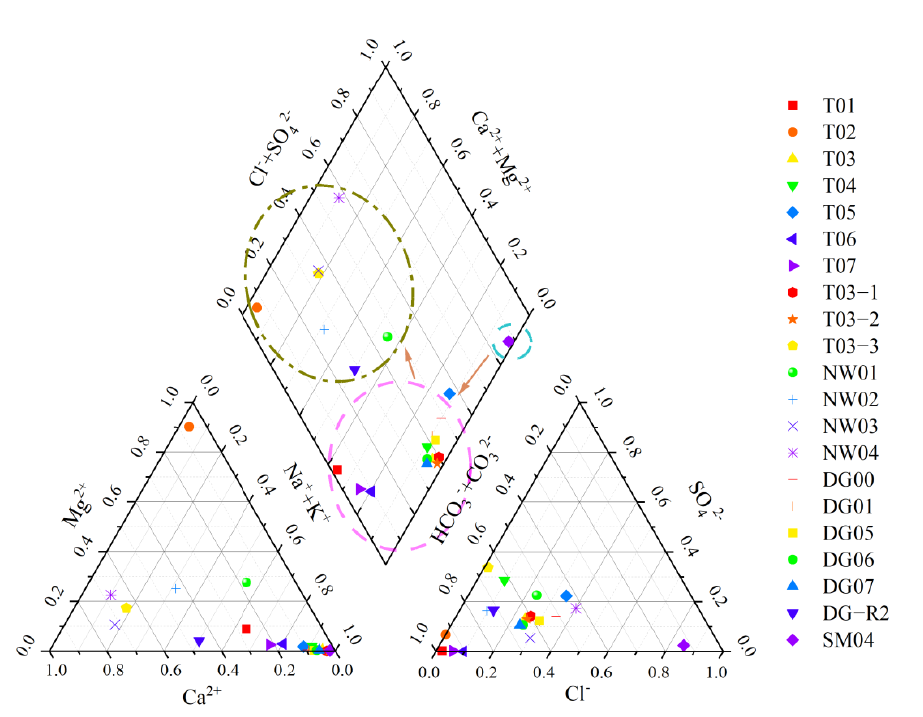
Figure 3. Piper diagram of water samples along the TNR.